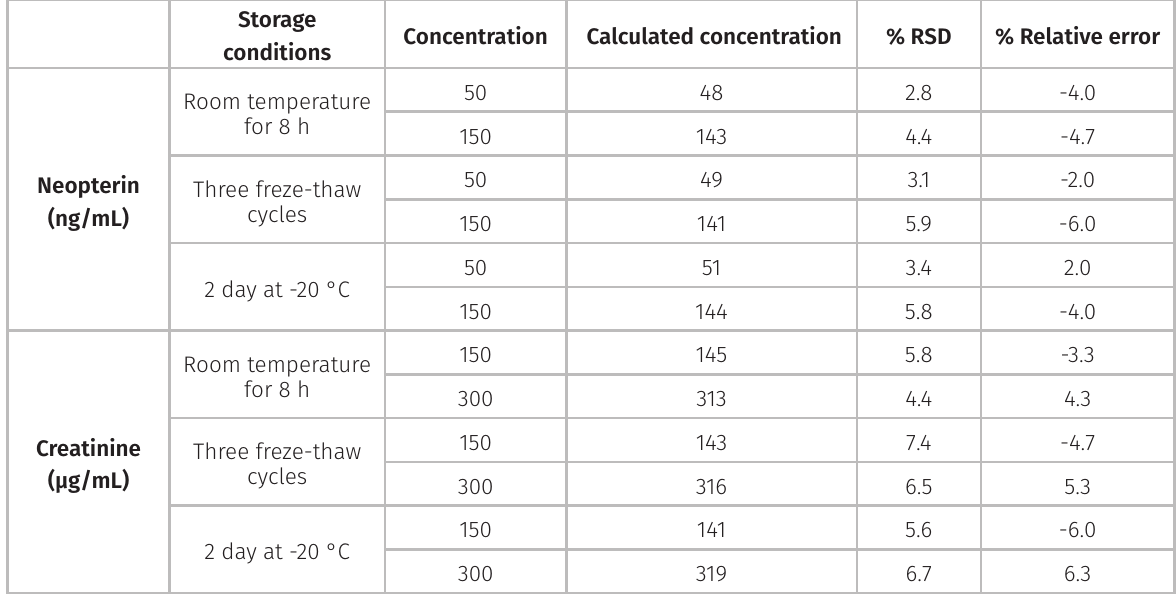
Table III. Stability of neopterin and creatinine in human urine under various storage conditions ( n = 3). Storage